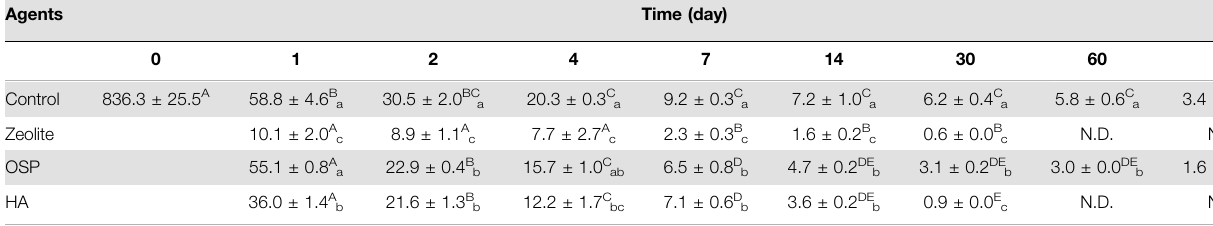
TABLE 5 | Concentrations of LMG ( μ g/L) in freshwater after treating with three agents (200 mg/L) at observation point during 90 days. Agents